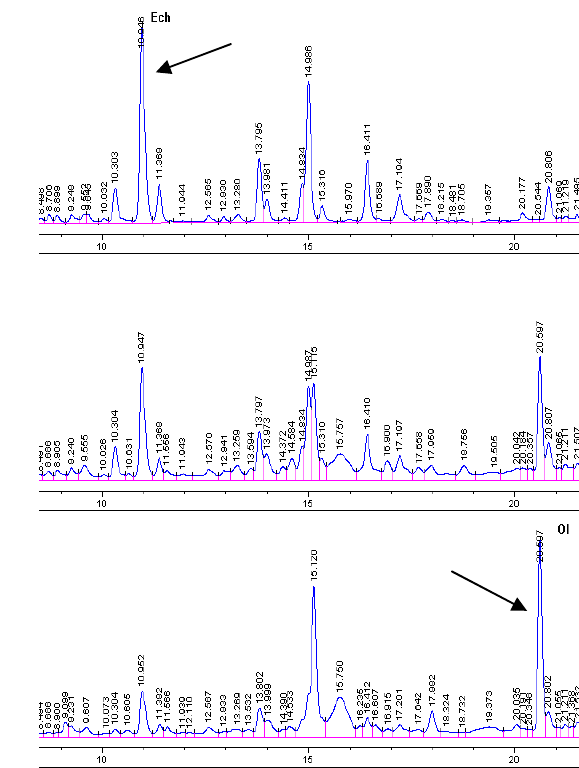
Figure 2. HPLC chromatograms of echinacoside and oleuropein standard solutions and a lyophilized water infusion of Ligustrum vulgare L. leaves . For HPLC conditions, see the Experimental